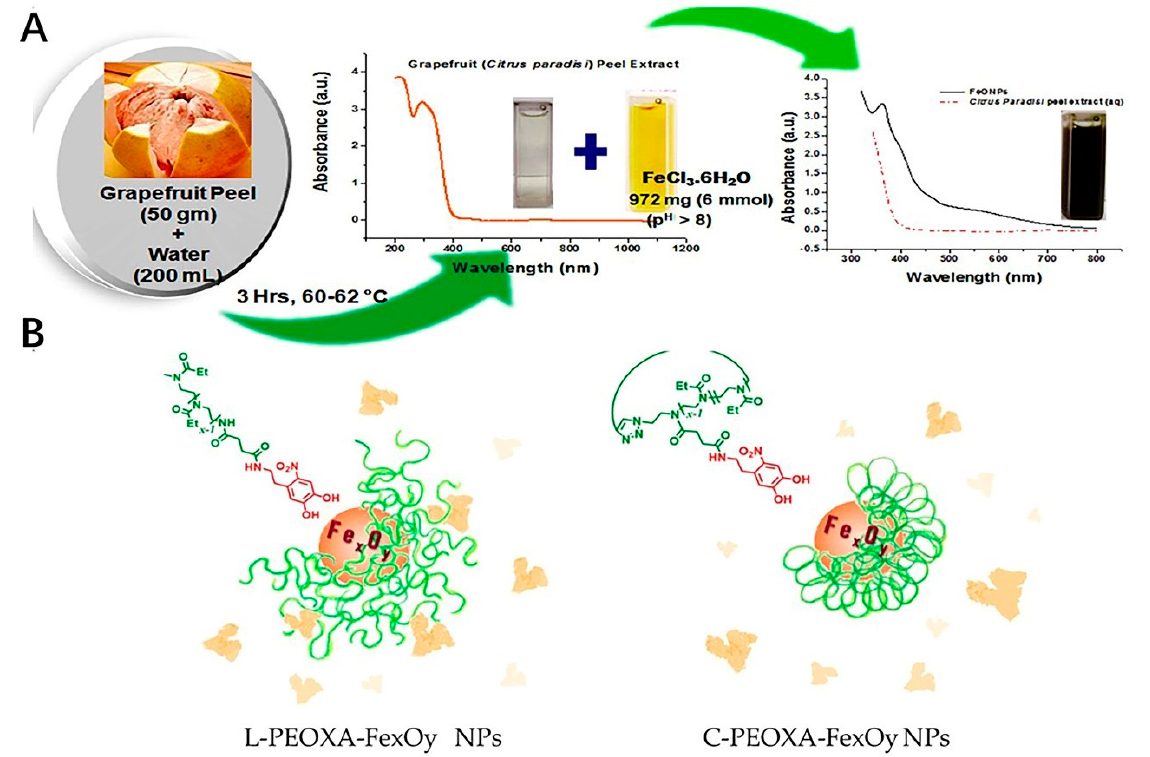
Figure 3. Examples of the fabrication process of the iron oxide nanoparticles. ( A ) Schematic repre- sentation of biosynthesis of FeONPs. ( B ) Surface modification of the nanoparticles. L − PEOXA − Fe x O y and C − PEOXA − Fe x O y NPs show different stability in HSA. Cyclic PEOXA shells could quantita- tively prevent the formation of a protein corona. Linear brush shells cannot be entirely prevented.